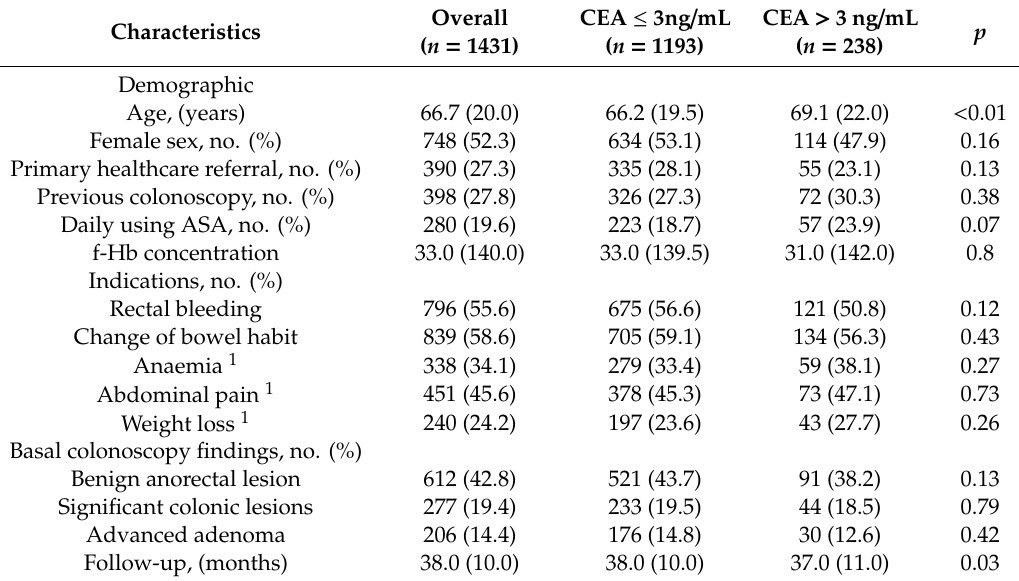
Table 1. Characteristics of the individuals included in the